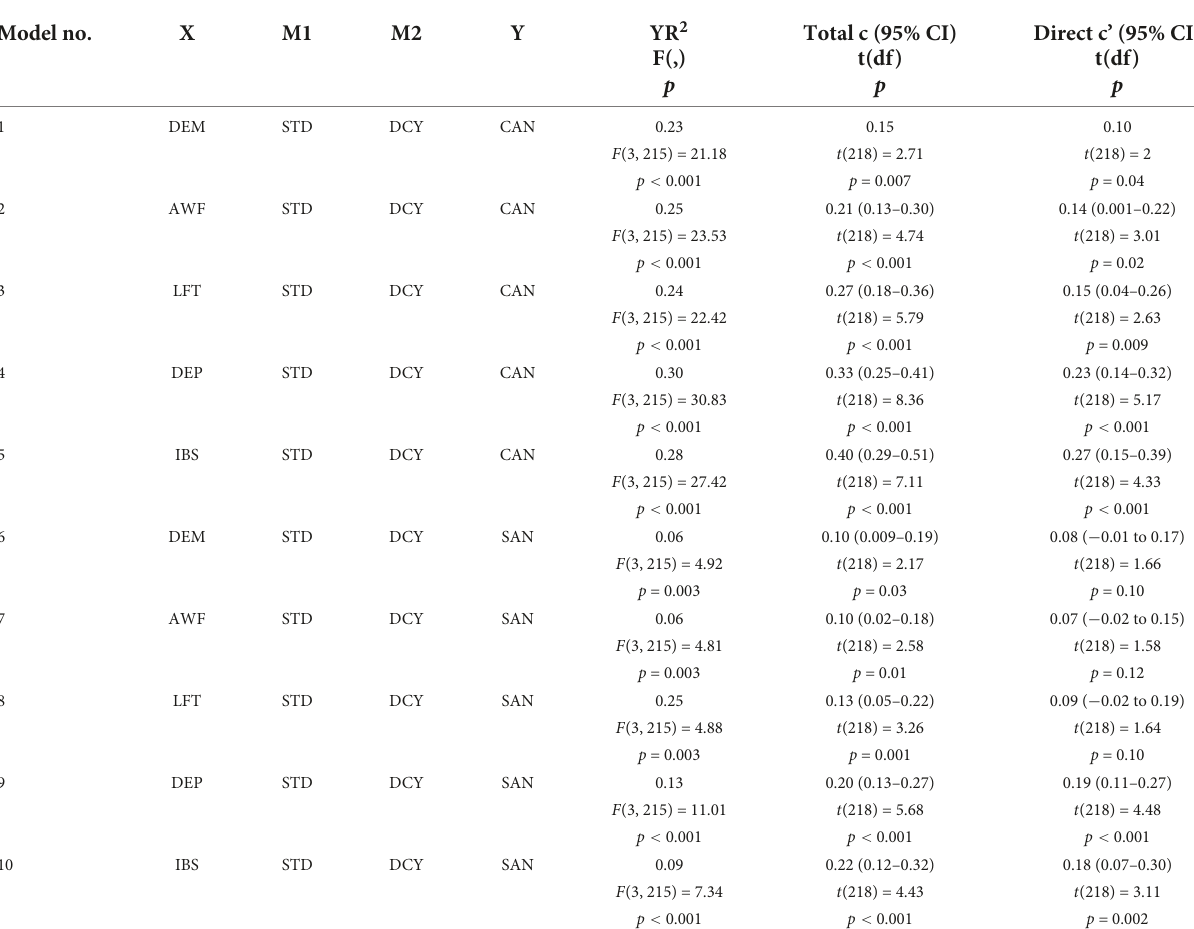
TABLE 2 Serial atemporal multiple mediation analysis results. Model